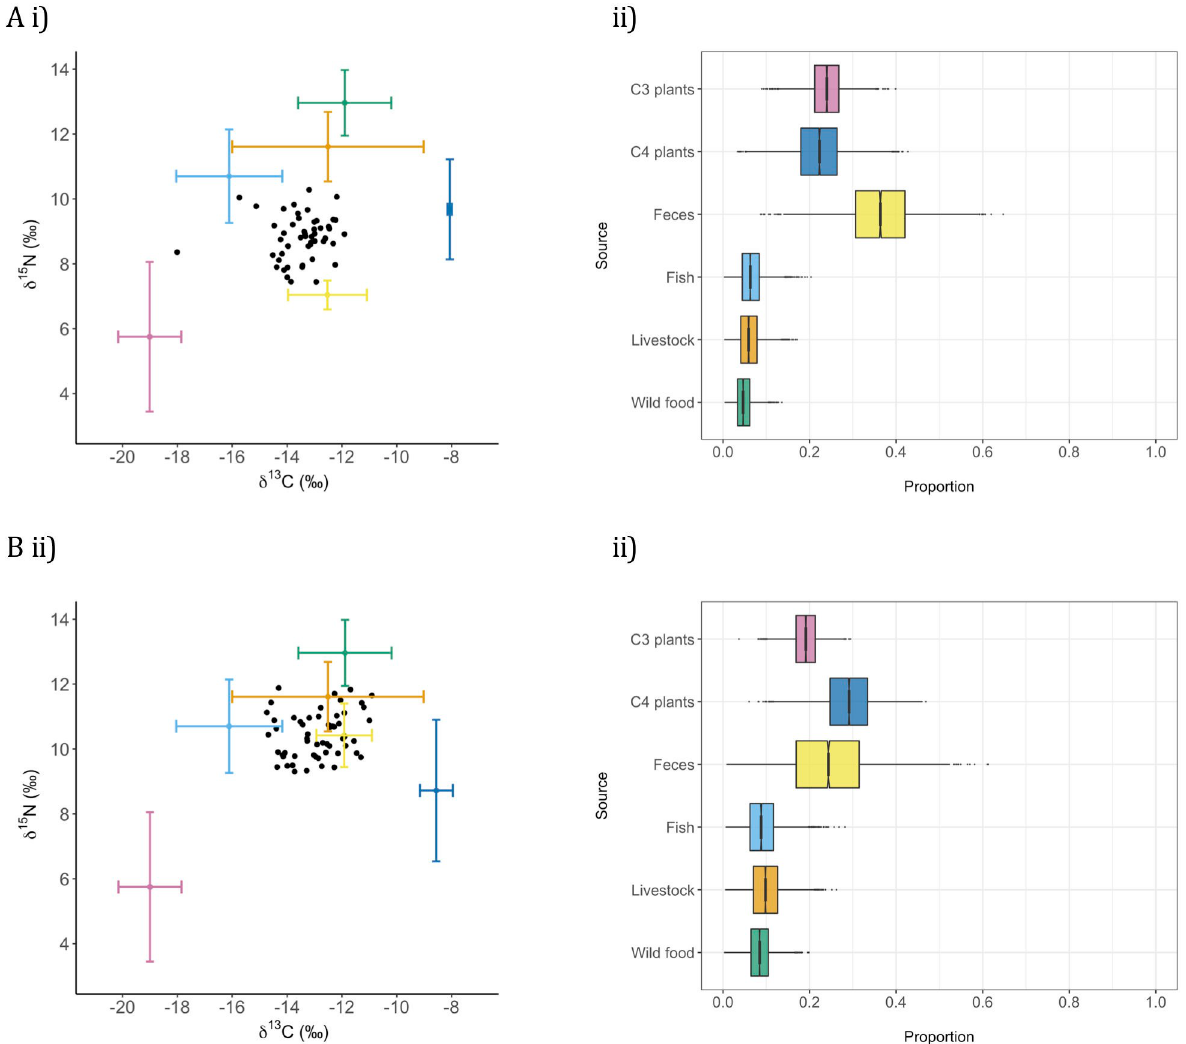
Fig 3. Stable isotope analysis of the diets of dogs in two settlements in Chad. Settlements are A) Kakale and B) Magrao. i) The δ 15 N and δ 13 C values for sampled dogs (black dots) and the mean ± standard deviation of δ 15 N and δ 13 C for putative food groups. Trophic discrimination factors, derived from package SIDER, have been applied to adjust dog isotope ratios downwards for both δ 15 N and δ 13 C. ii) Outputs of Bayesian mixing models, from package SIMMR, of the proportional contributions of the main food groups to dog